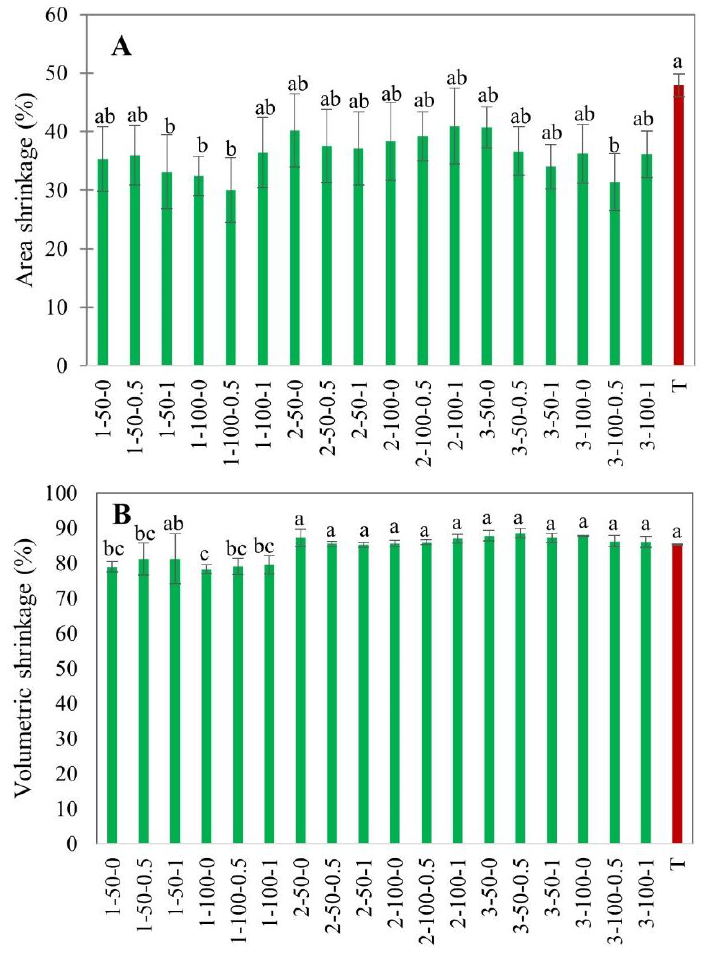
Figure 9. Area ( A ) and volumetric ( B ) shrinkage of EHD (marked in green and labeled as thickness- slice load density-airflow) and hot air-dried (marked in red as T) apple slices. Different lower-case letters indicate statistically significant differences ( p < 0.05).